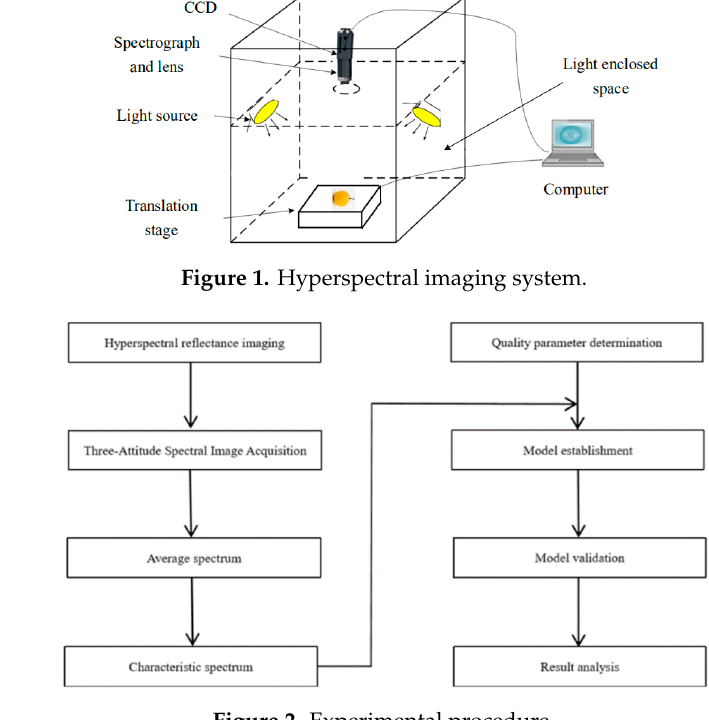
Figure 2. Experimental procedure.